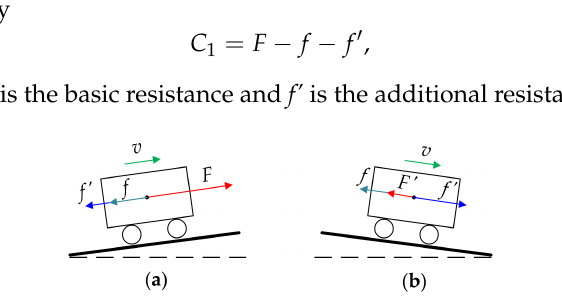
Figure 2. Train stress diagram, ( a ) the uphill traction; ( b ) the downhill